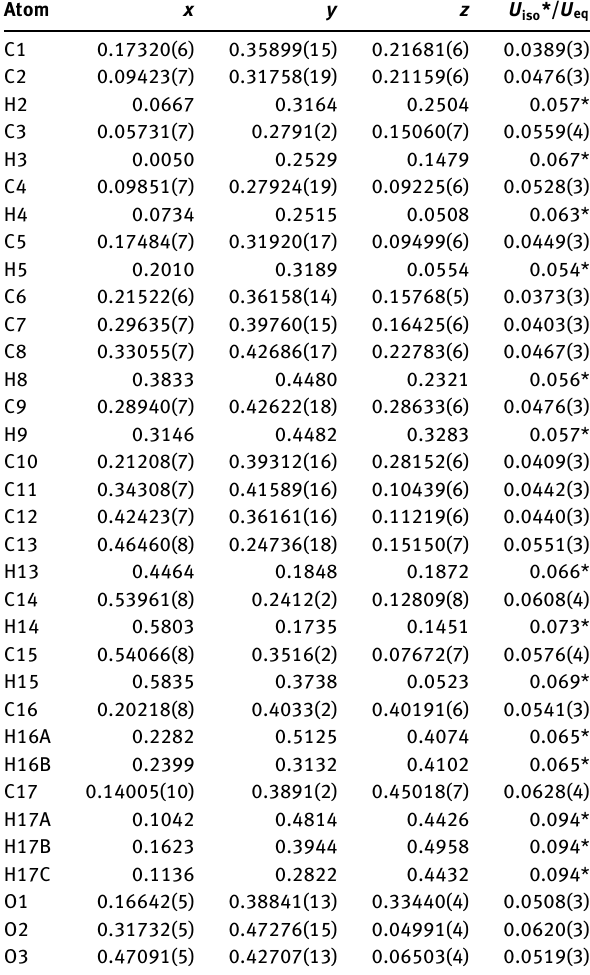
Table 2: Fractional atomic coordinates and isotropic or equivalent isotropic displacement parameters (Å 2